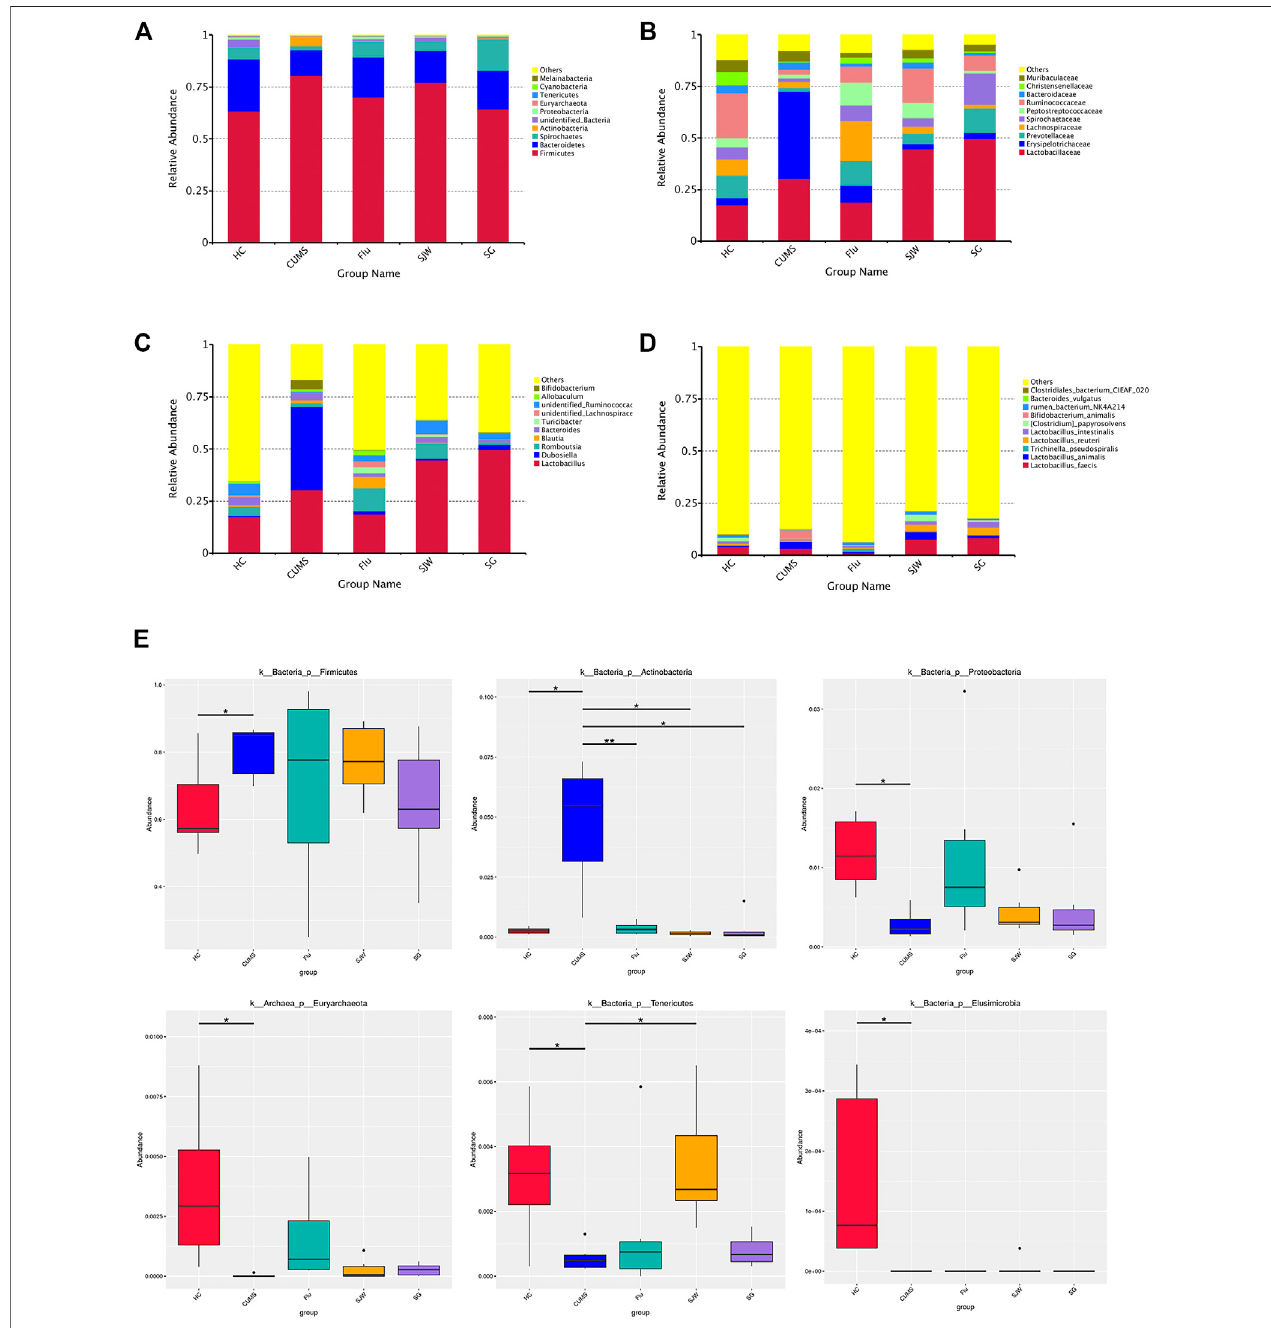
FIGURE 7 | Fecal microbiota changes following antidepressant treatments at the phylum, family, genus, and species levels. Community bar-plot analysis showed the relative abundance of sequences at the phylum (A) , family (B) , genus (C) , and species (D) levels. (E) The MetaStat method was used to test the species abundance databetweengroups,correctthe p -value,andthenobtaintheq-value. ThestatisticsoftherelativebacterialphylaabundancesinHC,CUMS,Flu,SJW,andSGgroups. Signi fi cant differences were indicated: *q < 0.05, **q < 0.01, ***q < 0.001. (k, kingdom level; p, phylum level).